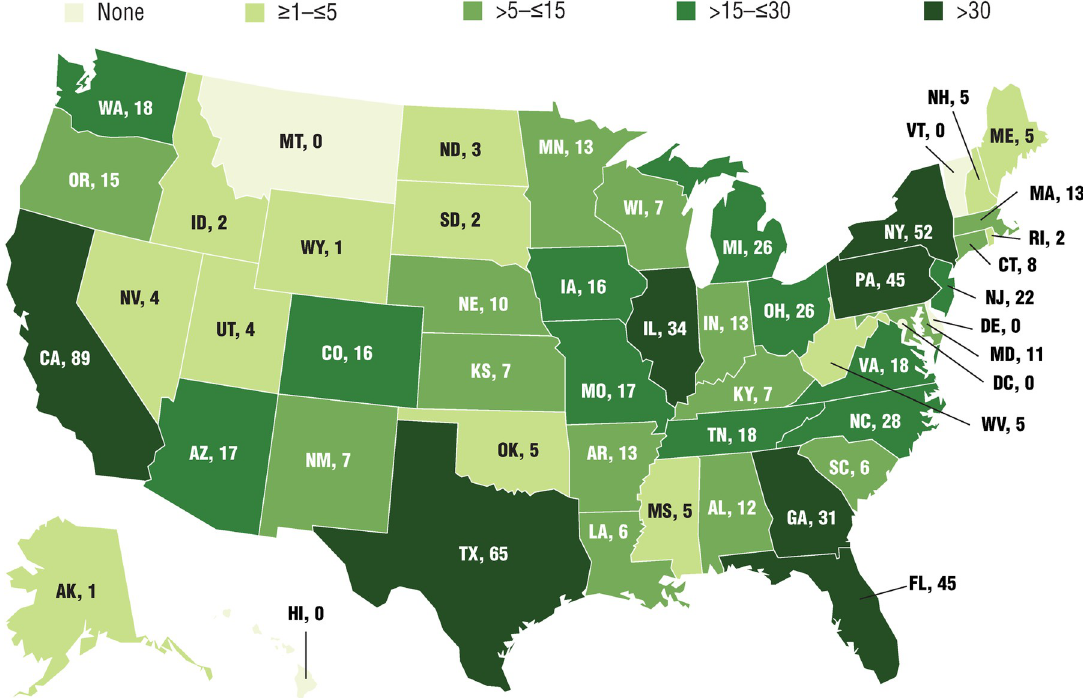
Fig 2. Number of survey respondents in each state. 775 respondents provided home state information.